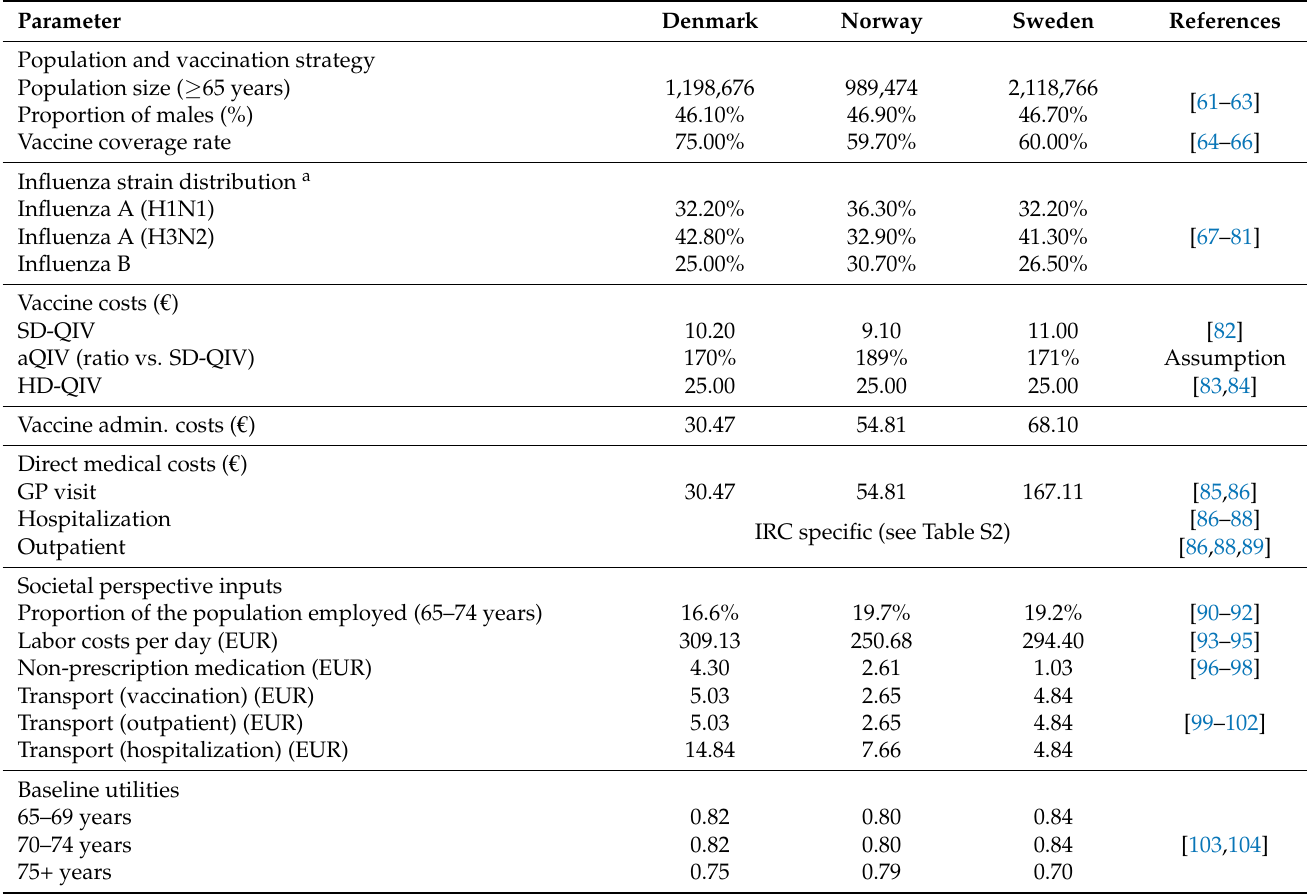
Table 2. Country-specific model